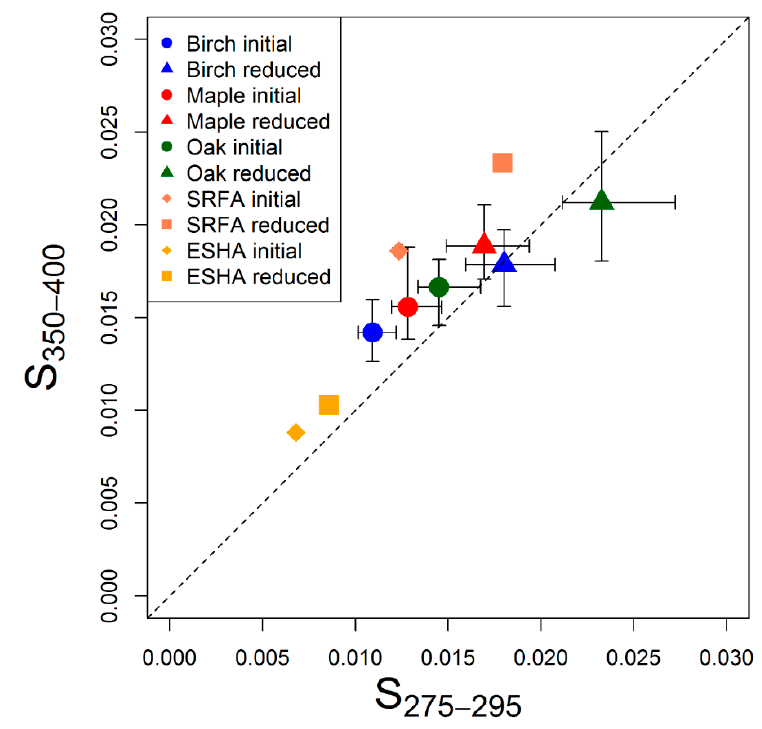
Figure 2. Mean absorption indices, S 275–295 and S 350–400, for leaf litter leachates. Borohydride treatment (reduced) causes increases in both metrics for all samples. Both spectral slopes do not appear to distinguish leaf leachates from HA and FA standards. Error bars indicate range of values for all four time points of each species. Dashed line indicates a spectral ratio of 1.